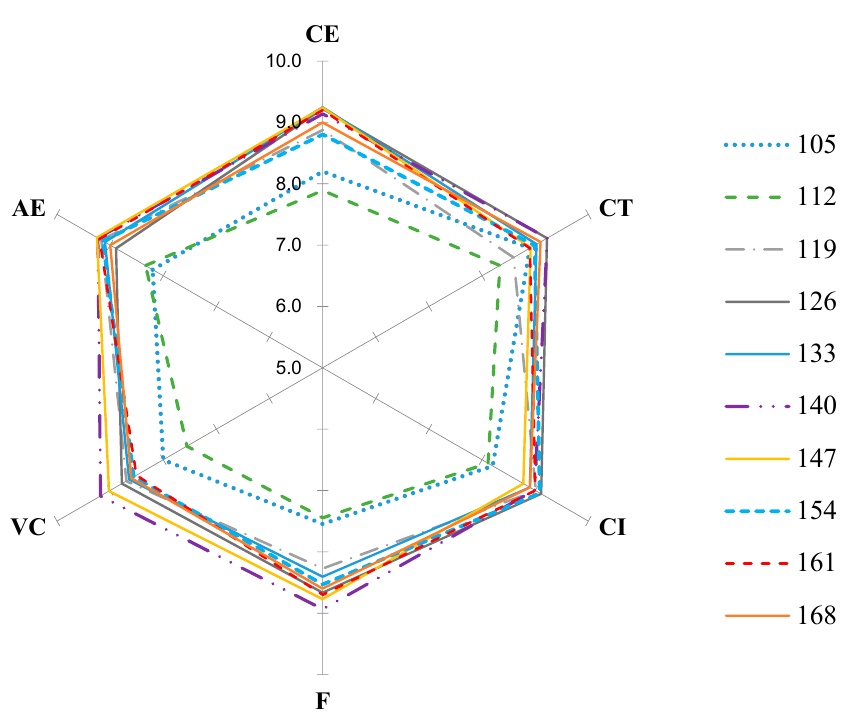
Figure 3. Sensory profile at consumption point, in relation to the harvest date (Days from full flowering). CE = Peel color; CT = Tactile firmness; CI = Pulp color; F = Flavor; VC = Overall evaluation; AE = Overall appearance.